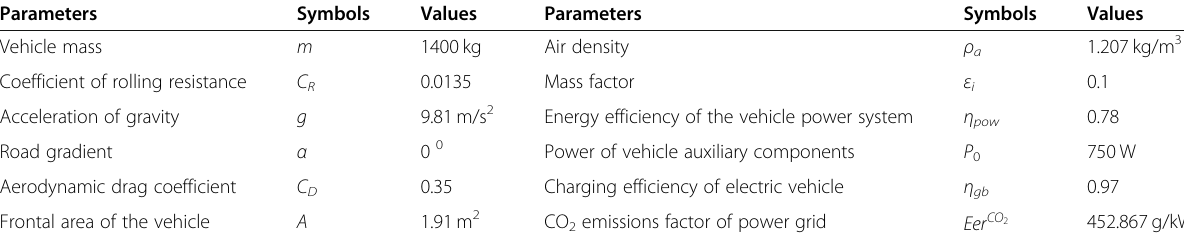
Table 4 Relevant parameters for the simulation of electric vehicle emissions